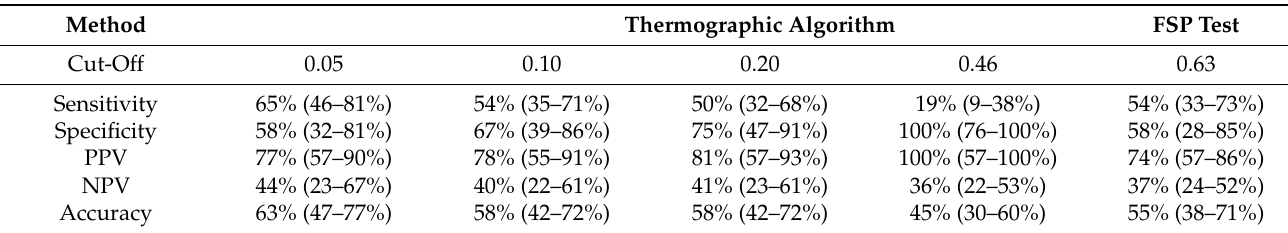
Table 3. Measures of the test performance for the finger systolic pressure (FSP) test and the evaluated thermographic algorithm with the clinical decision as the reference diagnosis ( n = 38). The thermographic algorithm is represented by four different predicted probability cut-off levels with associated 95% confidence intervals. PPV = positive predictive value. NPV = negative predictive